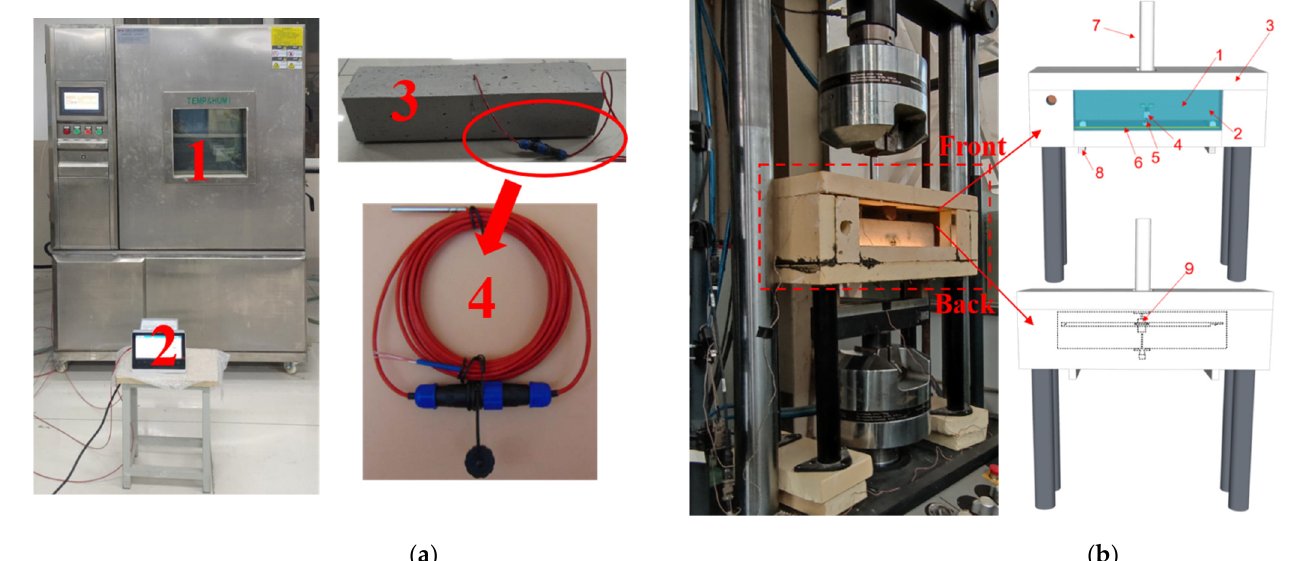
Figure 6. Cooling system and test setup (0, − 20, and − 60 °C ). ( a ) Cooling system. Note: 1—cooling refrigerator; 2—temperatures recorder; 3—temperatures control test specimen; 4—temperatures sensor. ( b ) Test setup. Note: 1—ECC specimen; 2—acrylic glass (observation window); 3—clip extensometer (CTOD) 4—clip extensometer (CMOD); 5—polycyanurate (heat preservation); 6—Led light (illumination); 7—loading head; 8—distribution beam; 9—displacement meter (using non- thermal conductive resin to make the clamping end).